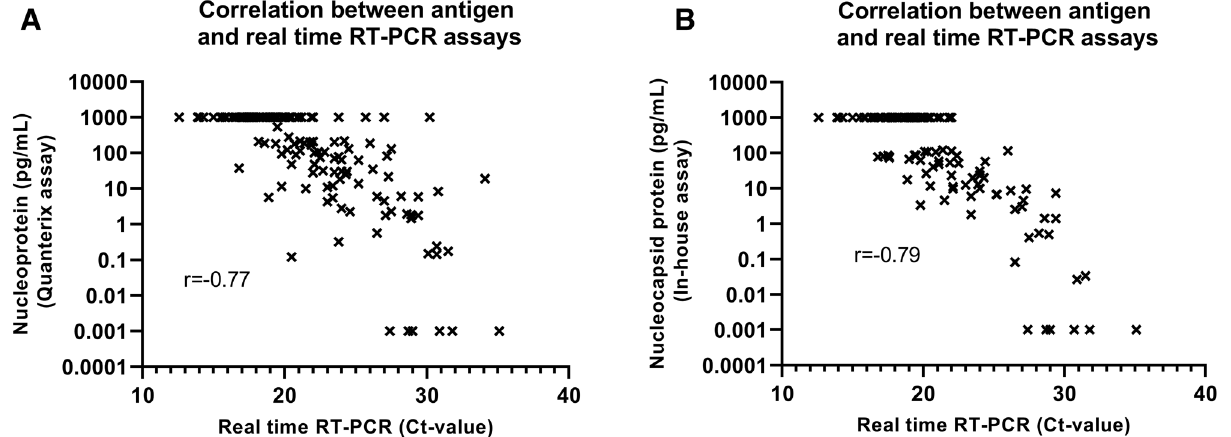
Figure 5. Correlation between nucleocapsid protein concentrations and real time RT-PCR Ct-values using the ( A ) Quanterix assay and the ( B ) in-house assay. The r values are